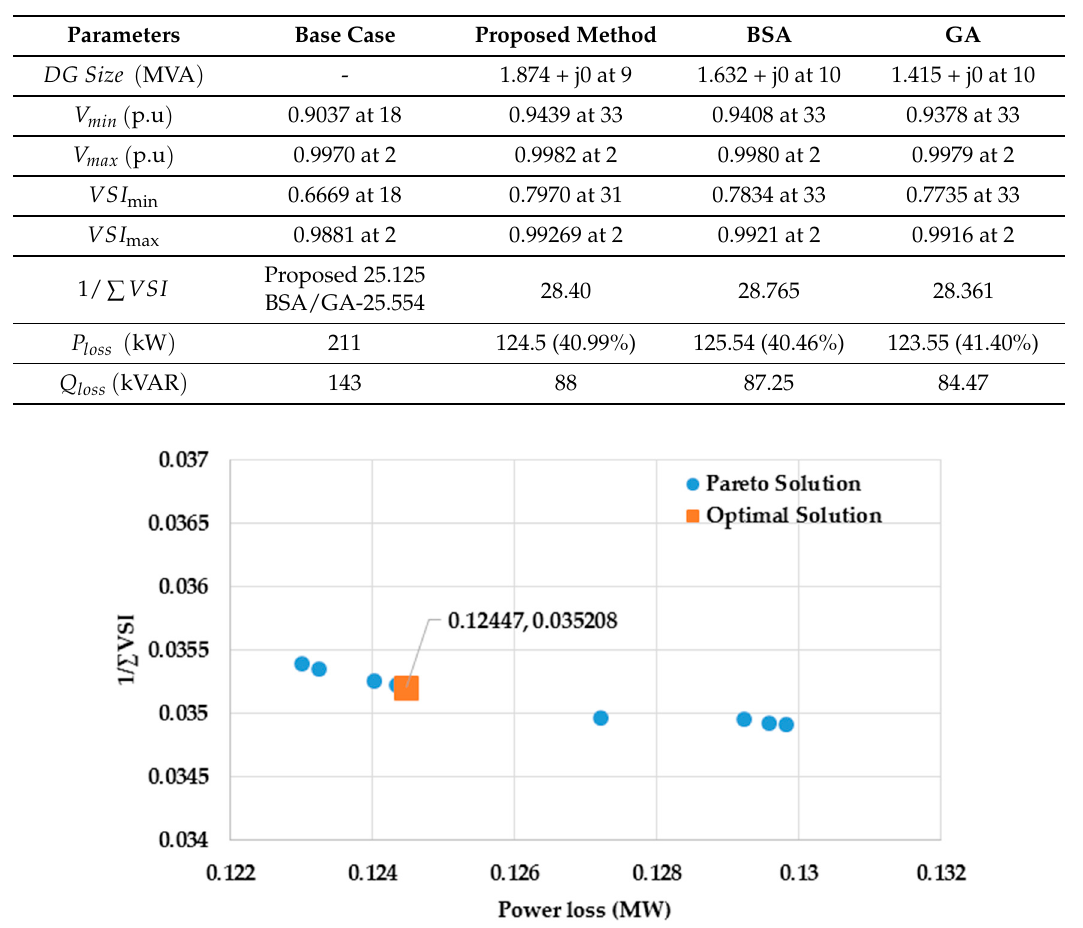
Figure 13. Pareto-solution and optimal compromise solution for Type-1 (1 DG).